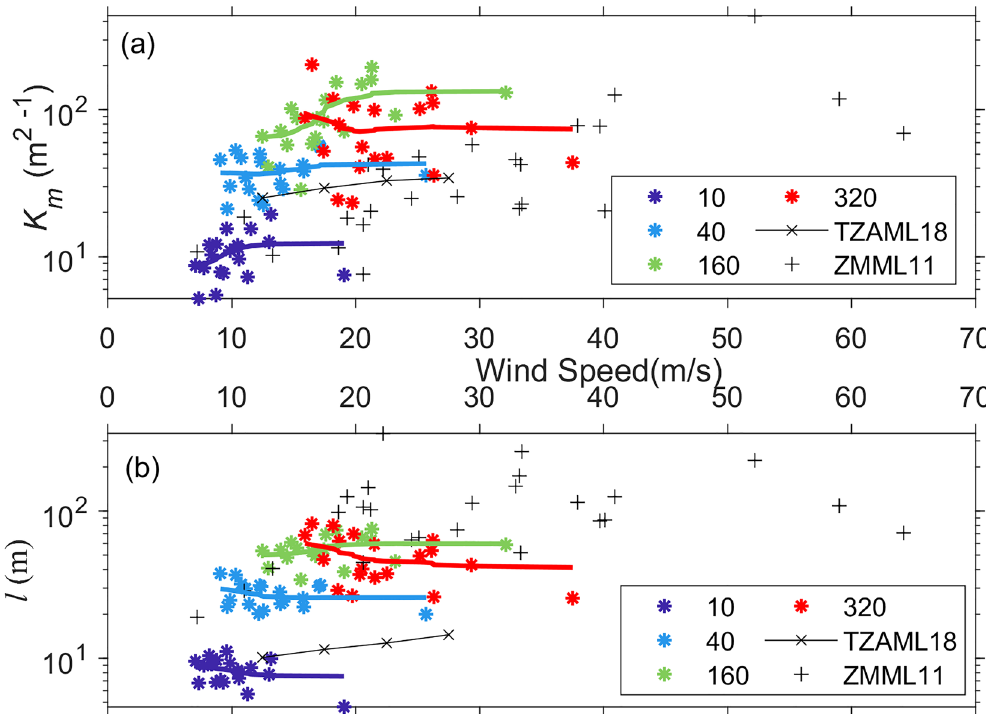
Figure 9. Plots of ( a ) vertical eddy diffusivity (K m ) and ( b ) vertical mixing length, at 4 vertical levels, as a function of the wind speed. TZAML18 stands for Tang et al. (2018), and ZMML11 stands for Zhang et al. (2011a). In ( a ) and ( b ), the best fit line at each level is also